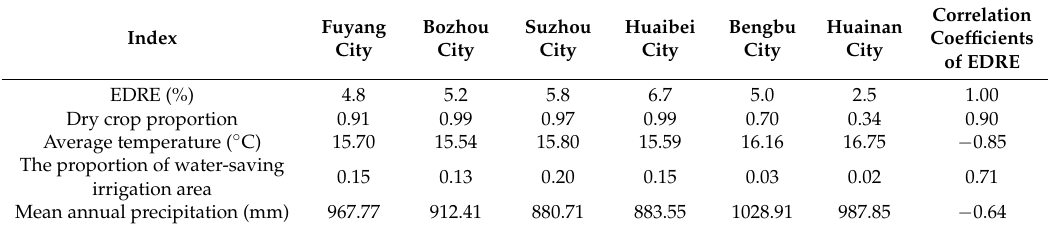
Table 3. Correlations between expectation of drought mitigation effects (EDRE) and its influencing factors in the study